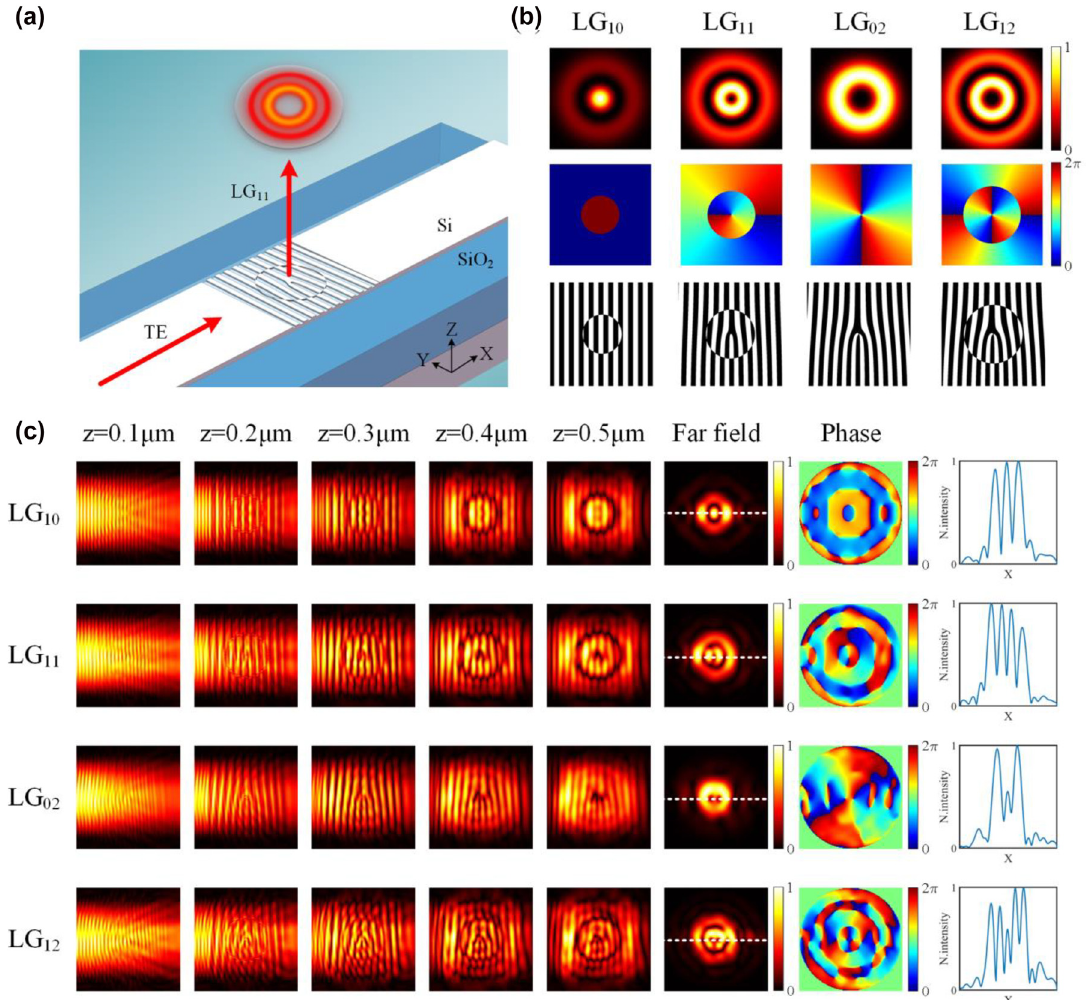
Figure 2: Simulation results for LG beam generation. (a) Schematic of the chip-scale broadband LG beams generator based on the holographic subwavelength grating. (b) The intensity and phase distributions of LG beams with different orders as well as the corresponding holograms. (c) Simulated electric field distributions along the waveguide at different height of the grating region, including the amplitude profiles, phase profiles, and normalized longitudinal intensity